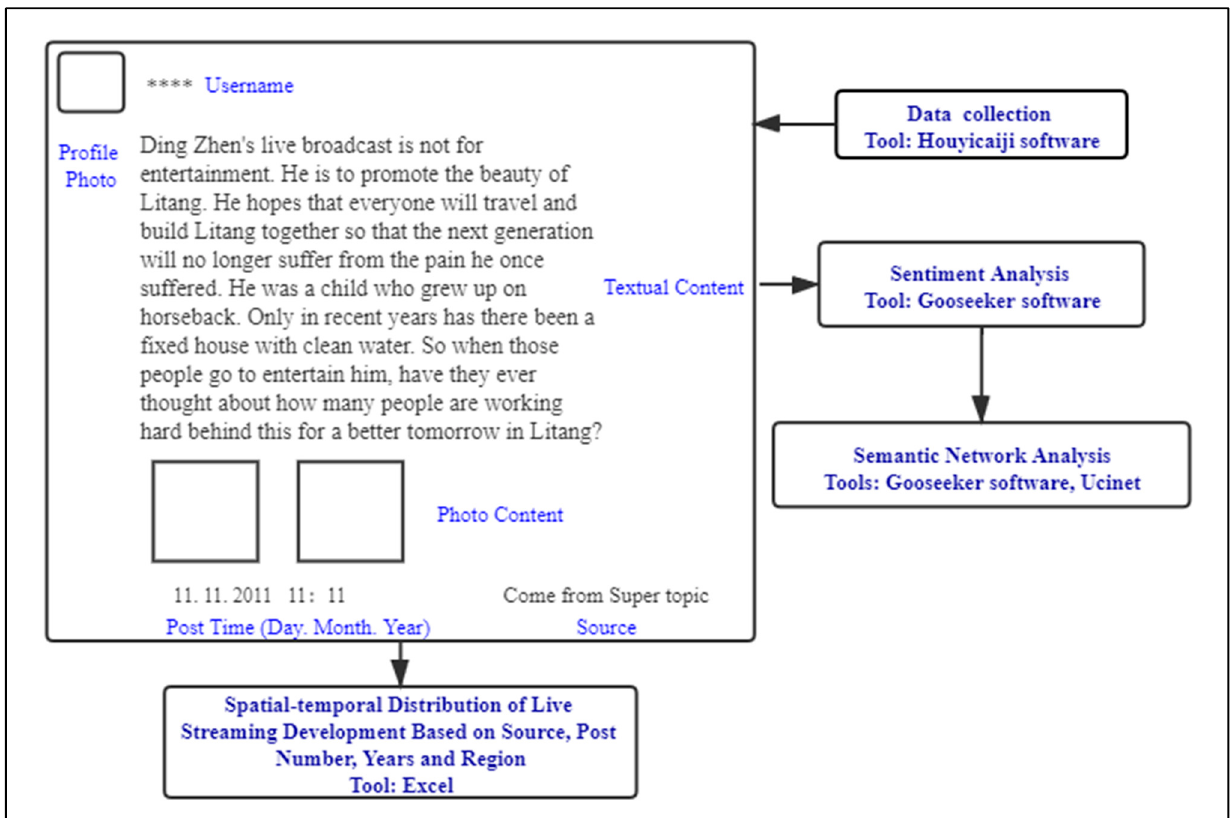
Figure 1. Weibo data content analysis flowchart.